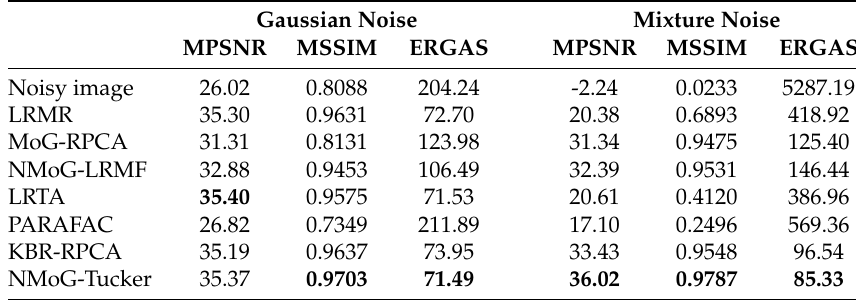
Table 3. Quantitative performance of different methods on MSI denoising. Every result is an average over six testing MSIs. The best results are highlighted in bold.